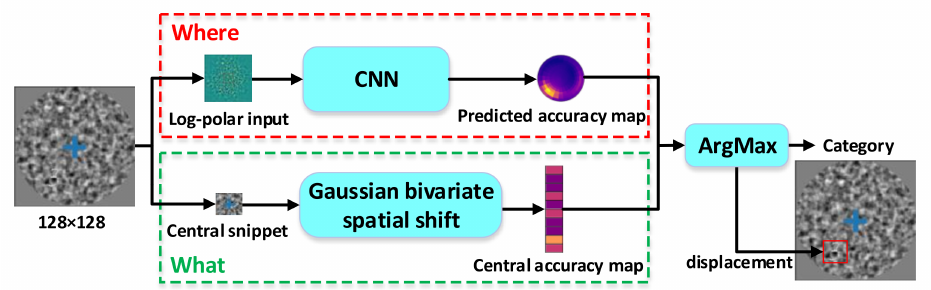
Figure 12. Computational graph of the method proposed by Emmanuel et